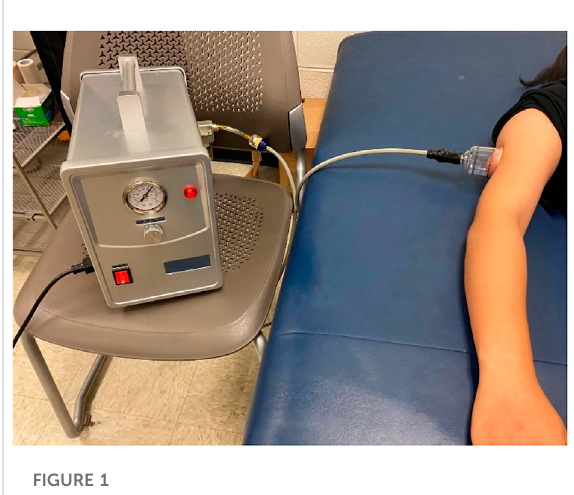
FIGURE 1 Photograph of the electronic negative pressure device (cupping device) and the setup of the cupping